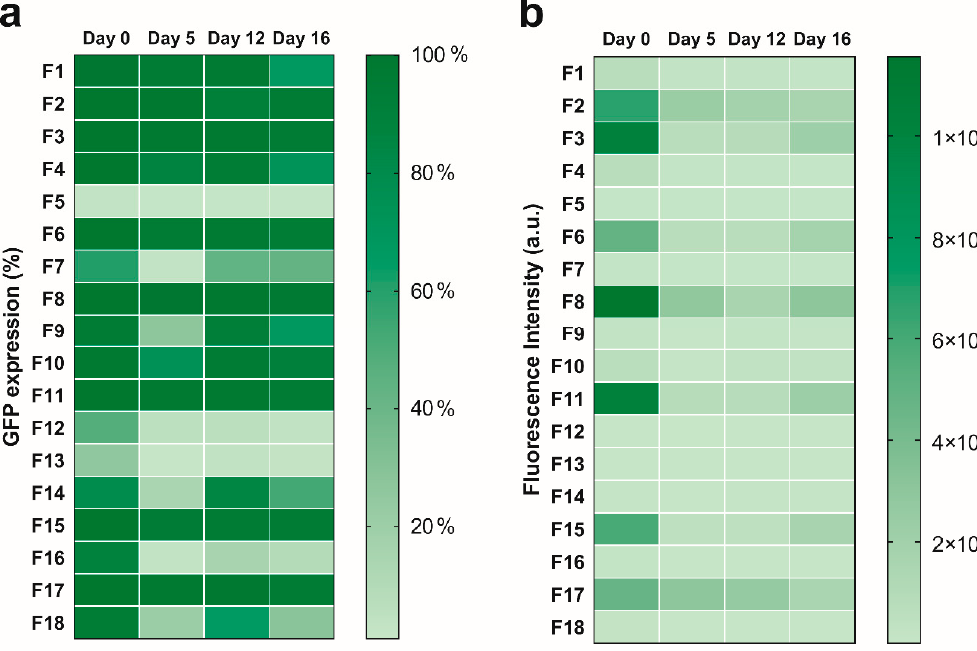
Figure 2. Efficiency of intracellular protein expression in HEK-293 cells over 16 days after LNP preparation. ( a ) percent GFP expression, and ( b ) fluorescence intensity.